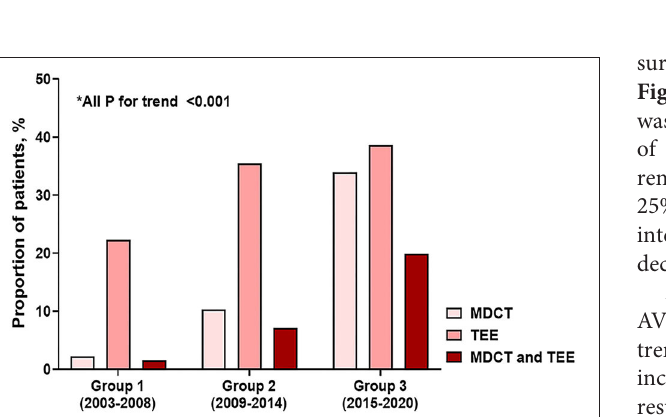
FIGURE 2 | Temporal trends in the use of additional diagnostic